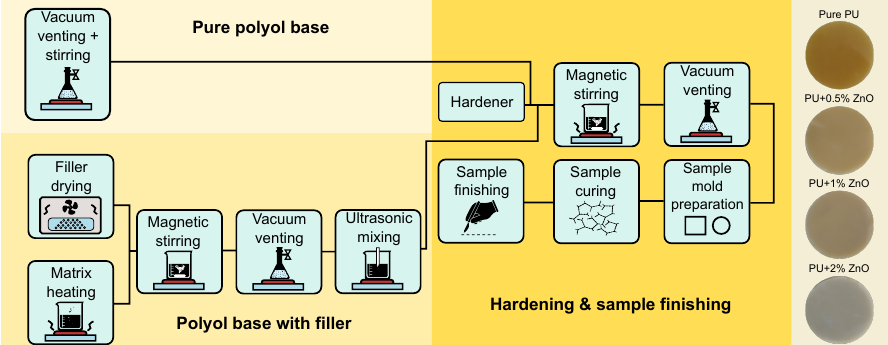
Figure 1. Scheme of preparation of PU/ZnO nanocomposites.